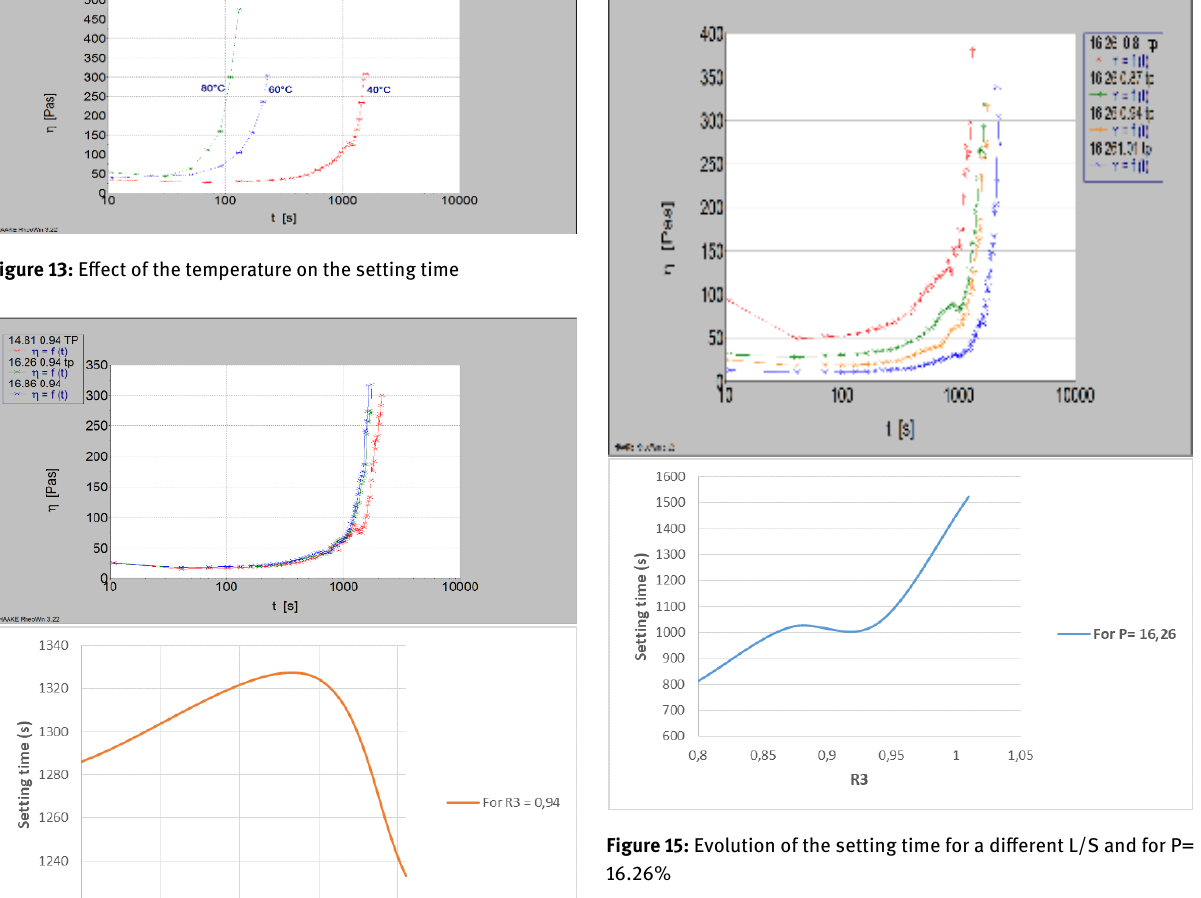
der on the one hand and to specify the desired setting